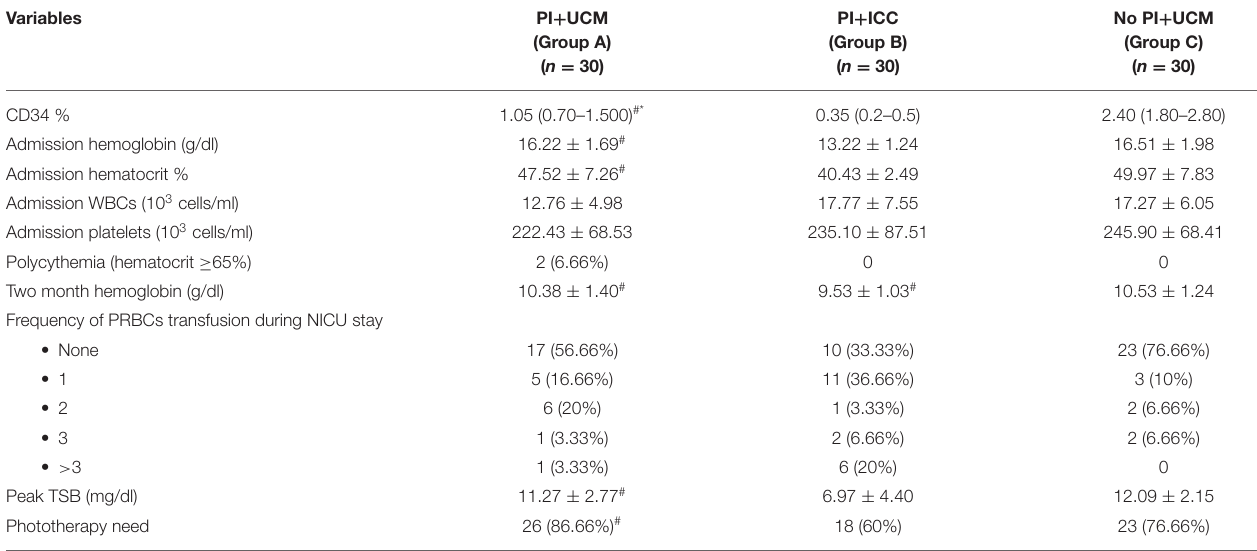
TABLE 2 | Hematologic parameters and outcomes between both